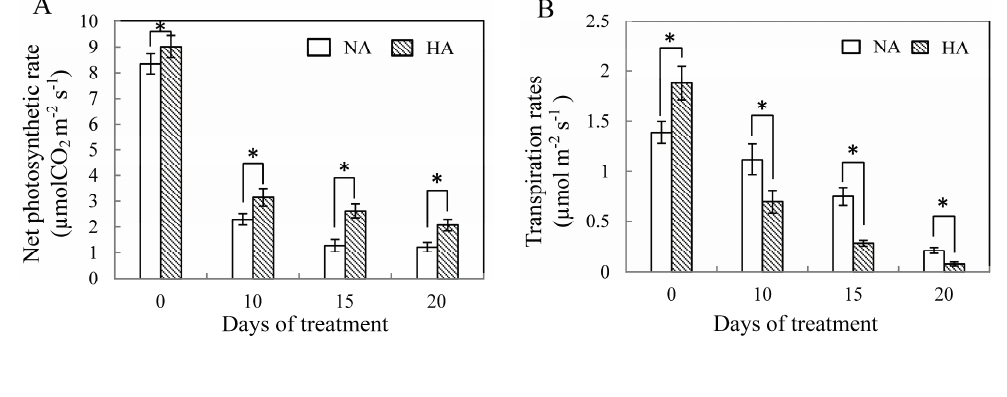
Figure 1. Changes in the amount of net photosynthetic rate ( A ), transpiration rates ( B ), water use efficiency ( C ), stomatal conductance ( D ) and intercellular CO for NA and HA under heat stress for 20 days. Columns marked with asterisks indicate significant difference between measurements made at 0, 10, 15, and 20 day of treatment for a given treatments based on a least significant difference test ( p ≤ 0.05). Data are provided as mean ± SE of four independent